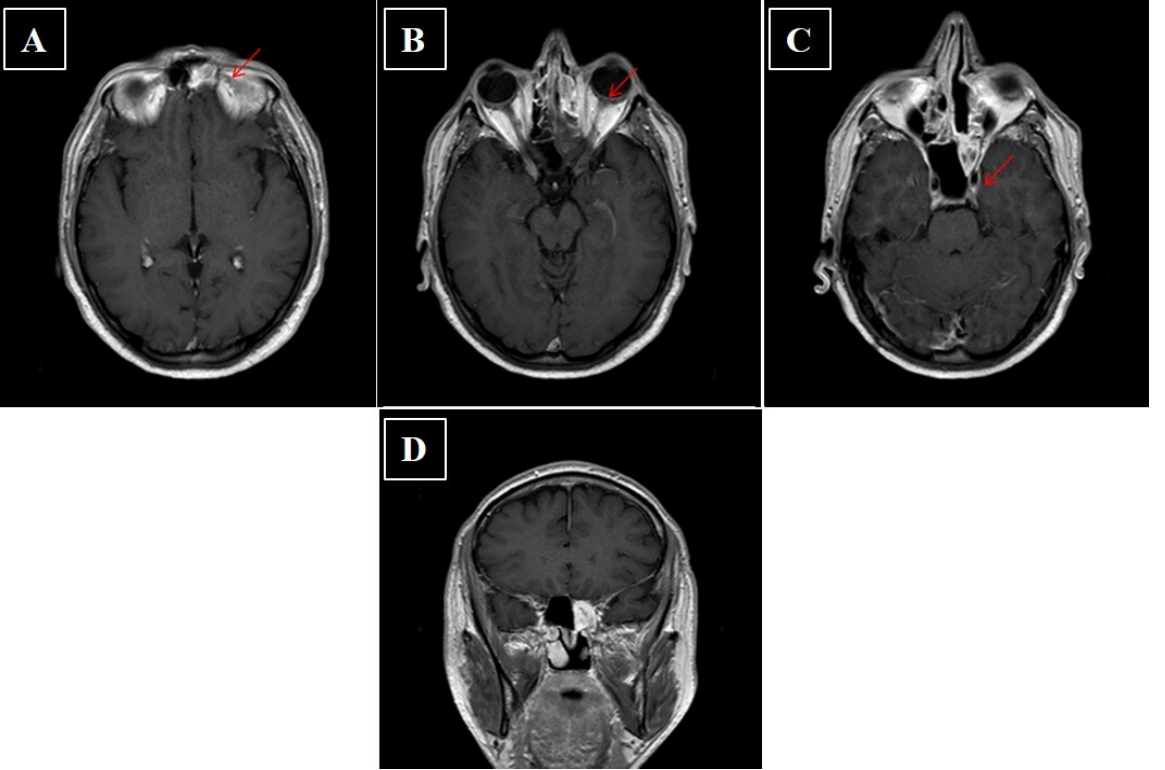
Figure 6. ( A , B , C , D ) Axial and coronal contrast enhanced fat-suppressed T1-weighted image CT scan of head performed after surgery. The arrow indicates persistence of inflammatory tissue.